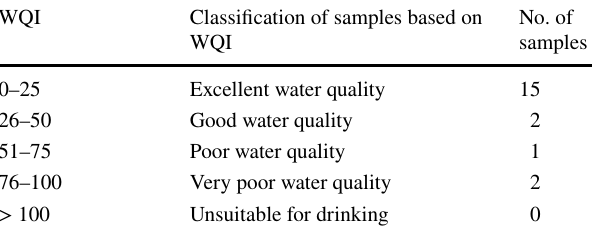
Table 4 Classification of groundwater on the basis of water quality index (WQI) WQI Classification of samples based on